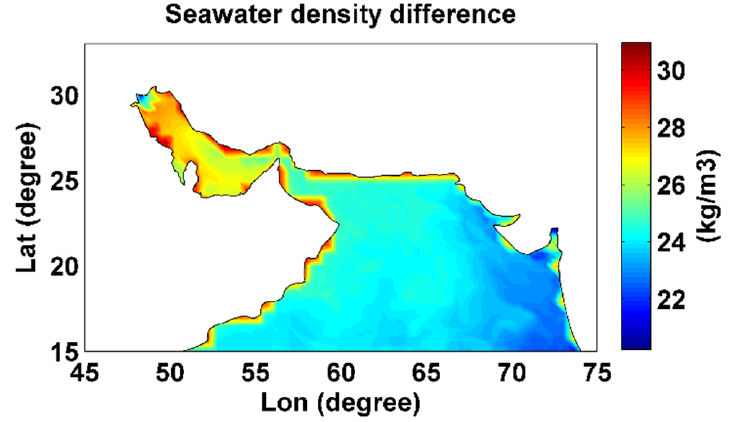
Figure 15. SSCs in the Persian Gulf and Oman Sea regions after the data assimilation of observations at 3:00 a.m. on 1 January 2008: ( a ) the whole area, ( b ) Persian Gulf, ( c ) Strait of Hormuz, ( d ) Oman Sea, ( e ) North Indian Ocean adjacent to Oman, ( f ) North Indian Ocean adjacent to India, ( g ) Oman Sea adjacent to Pakistan, and ( h ) Oman Sea and North Indian Ocean.